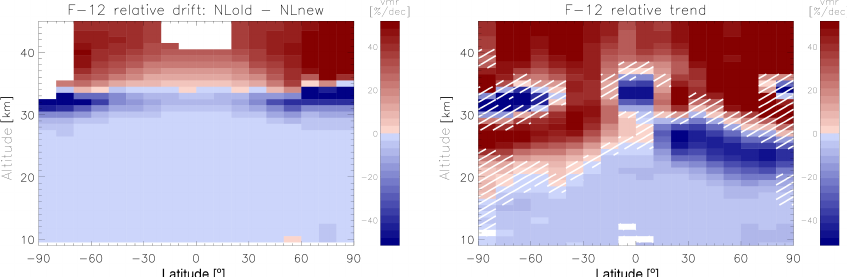
Figure 35. Left panel: altitude–latitude cross section of the instrument drift in MIPAS CFC-12. Blueish tiles indicate that the new coefficients result in higher CFC-12 mixing ratios, while reddish tiles indicate the opposite. White areas indicate that there were too few or no data points available to estimate a drift properly. Right panel: altitude–latitude cross section of relative MIPAS CFC-12 trends, calculated from data covering January 2005 to April 2012. Blueish tiles indicate declining CFC-11 mixing ratios, while increasing mixing ratios are represented by reddish tiles. Hatching indicates that the trends are either not significant at 2-sigma level or that χ 2 is more than 10% different from